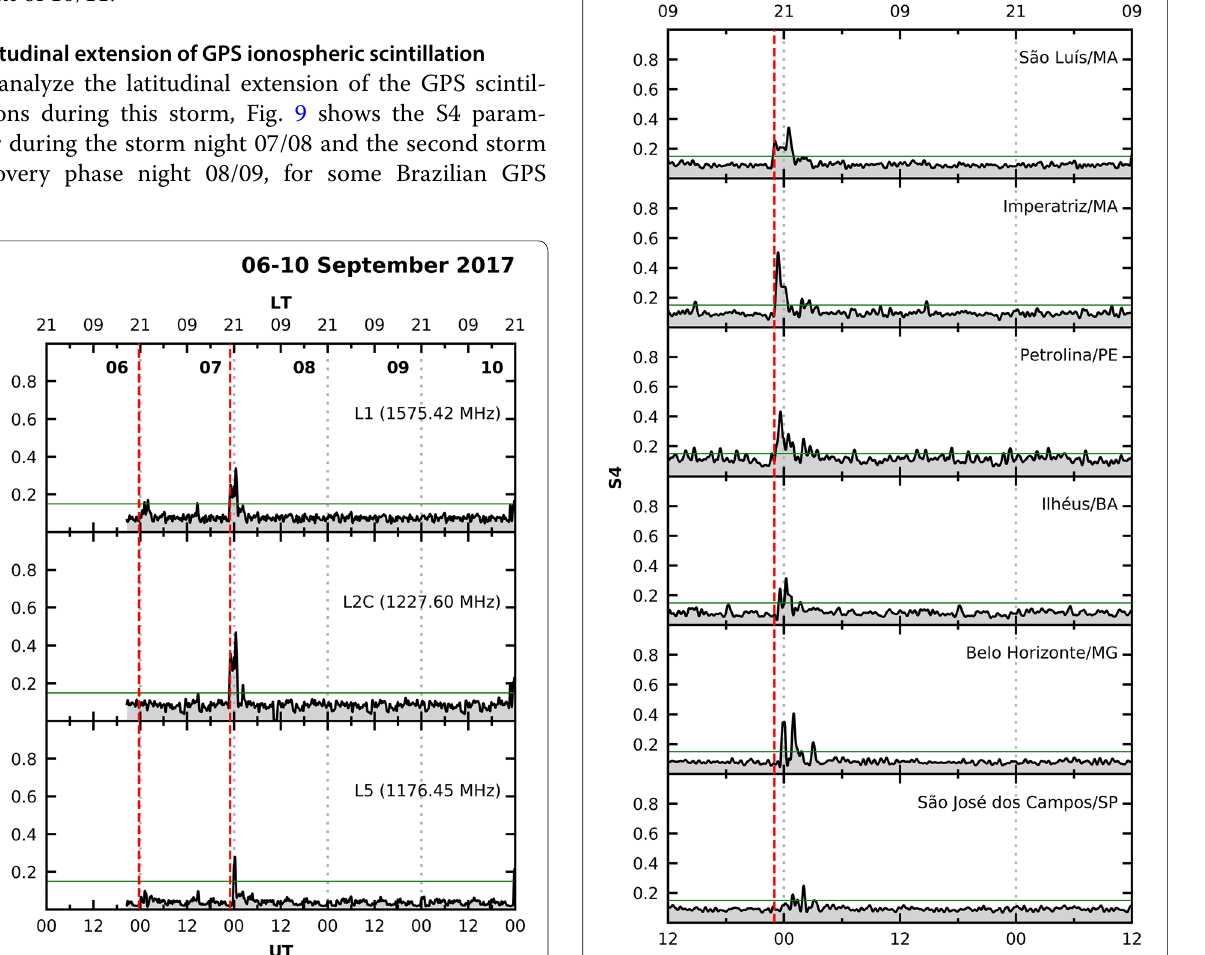
Fig. 9 S4 parameters from LISN GPS receivers from day 07 (12 UT) up to day 09 (12:00 UT). The green line is the noise threshold, i.e., we consider ionospheric scintillation when S4 > 0.15. The vertical dashed red line represents the SSC at 23:00 UT on day